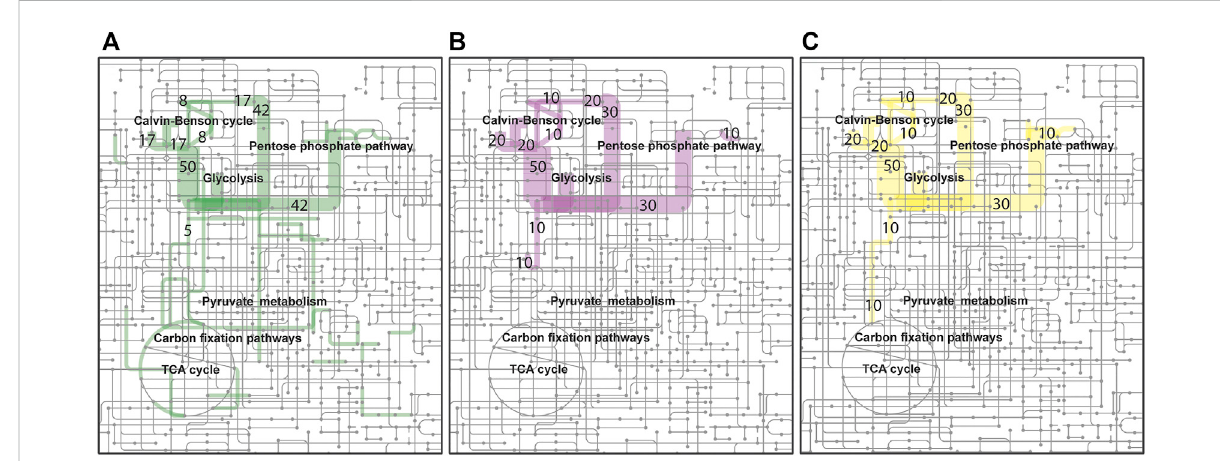
FIGURE 2 Autotrophic, H 2 oxidizing, metabolism of R. opacus DSM 43205. Flux distributions of optimal H 2 limited (A) growth (green), (B) lactic acid (purple), and (C) beta-alanine (yellow) production simulated using the reconstructed genome-scale metabolic model for R. opacus DSM 43205 are shown overlaid on the KEGG map of Microbial metabolism (id: map01120). The colored line widths indicate the fl ux magnitudes as relative fl uxes normalized to arbitrary limiting H 2 utilization of 100 mmol/(g CDW h) [ ≤ 4 mmol/(g CDW h) with same narrow width] with fl ux numbers for the highest fl